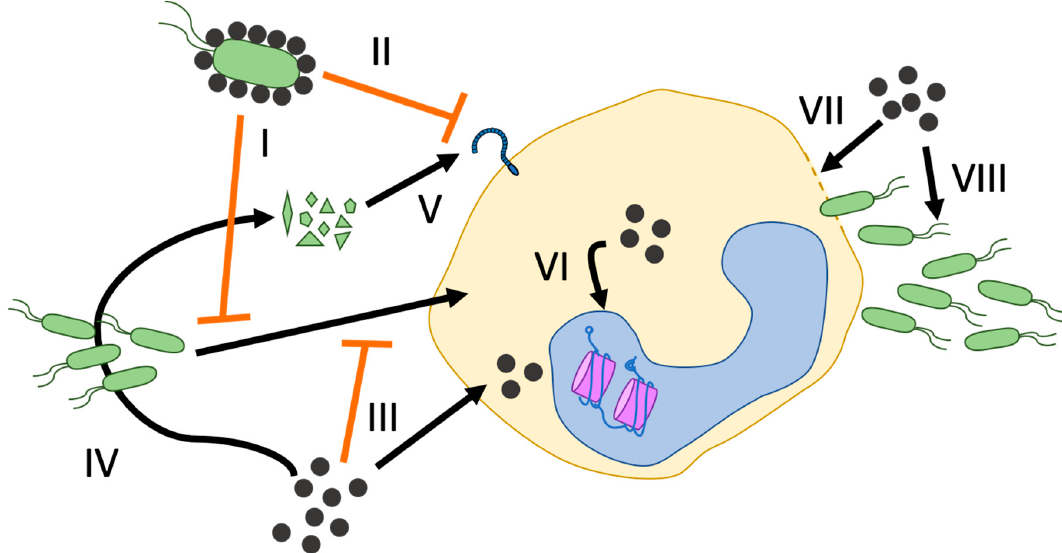
Figure 2. A schematic representation of the different avenues by which NPs may impact the innate immune response against bacteria. NPs (black dots) may interfere with the activation of innate cells (e.g., macrophages) by bacteria (green) in different negative and positive ways: (I) NP coating of bacteria can inhibit bacterial uptake into cells; (II) NP coating of bacteria can mask surface PAMPs and activation of cellular PRR; (III) NPs may compete with bacteria for cellular phagocytosis; (IV) NPs may have bactericidal activity resulting in release of PAMPs (small green polygons) leading to (V) PRR activation; (VI) NPs may induce epigenetic modifications (nucleosomes depicted in magenta); (VII) NP-mediated cytotoxicity causing cell membrane disruption and cell or tissue leakiness for bacterial invasion; and (VIII) NPs may enhance bacterial